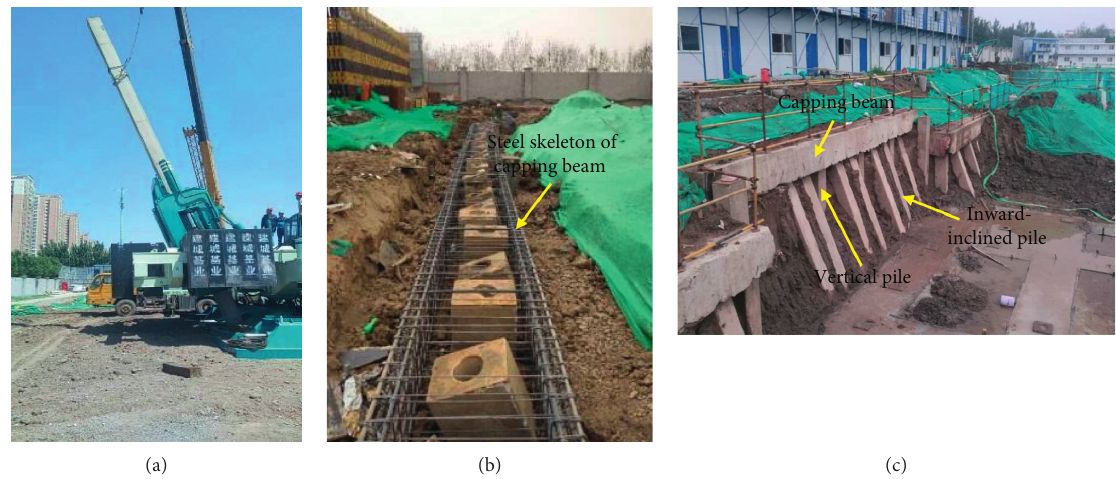
Figure 5: The site construction of inclined retaining structures. (a) Static pressure pile driver. (b) Construction of capping beam. (c) Excavation retained by VII 2 P-20 °